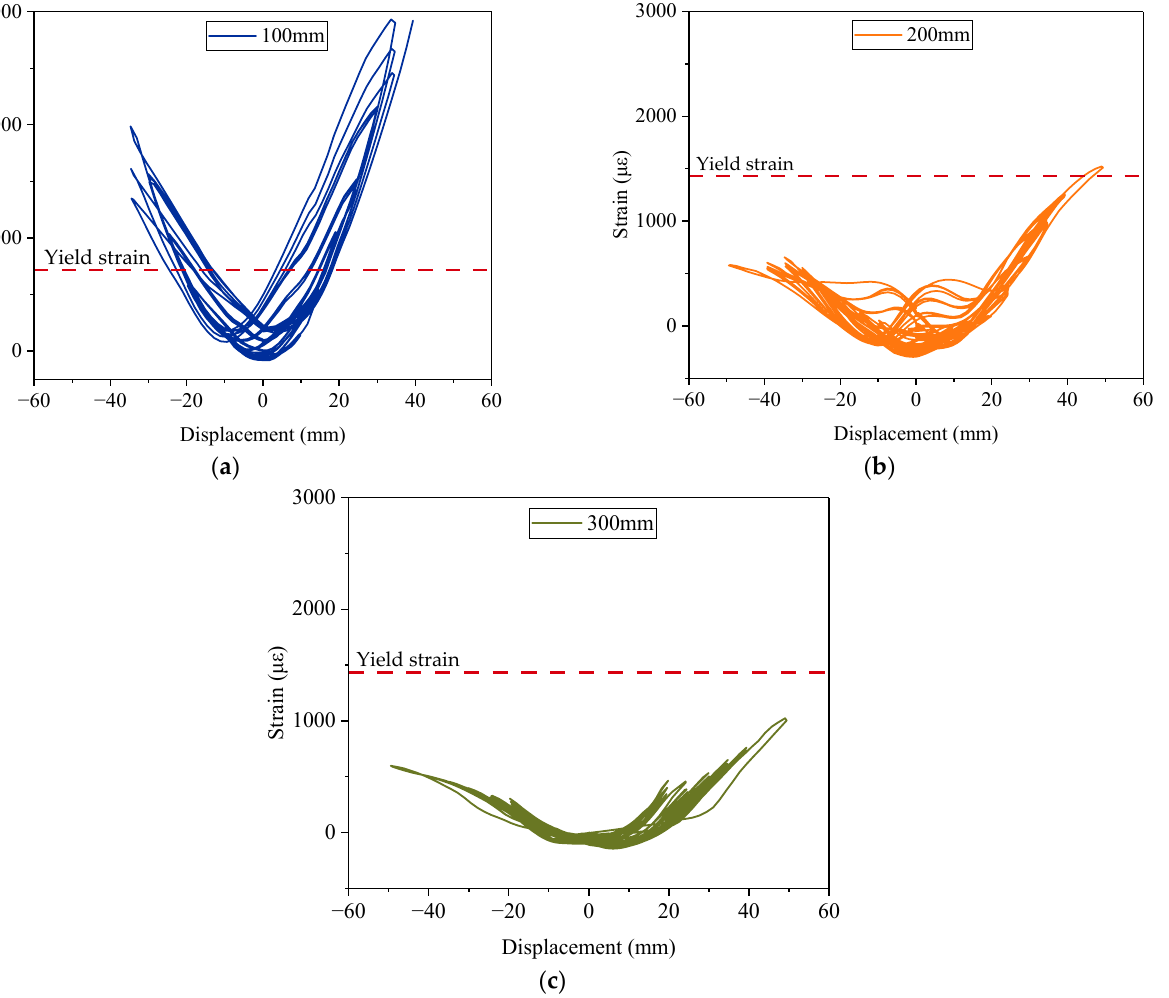
Figure 17. Measured strain of the column surface at different heights: ( a ) 100 mm height; ( b ) 200 mm height; ( c ) 300 mm height. height; ( c ) 300 mm